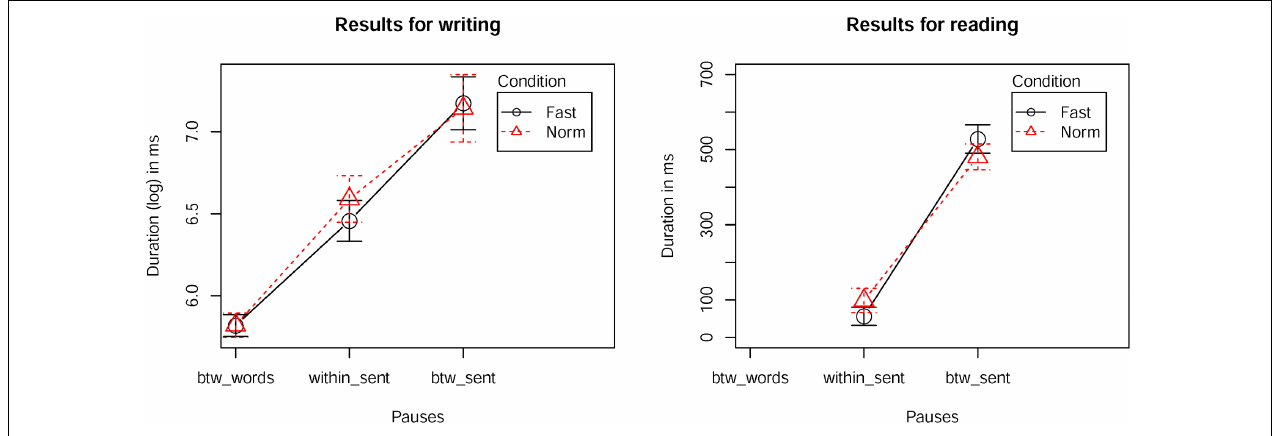
FIGURE 1 | Left: 95% confidence interval for interkey durations during typing: between words ( btw_words ), at commas ( within_sent ) and at full stops ( btw_sent ). Right: 95% confidence interval for the duration of pauses during overt reading at the same location as in typing. Different conditions ( Norm vs. Fast ) are plotted in red and black.